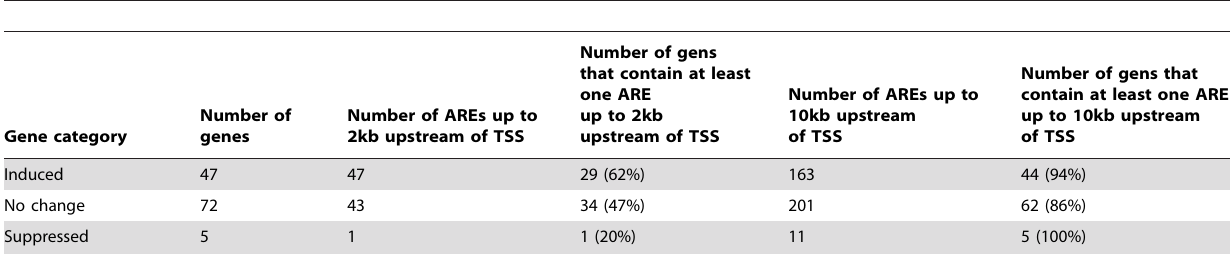
Table 1. Summary of total number of AREs in the 5 9 region of drug processing genes that were induced, not changed, and suppressed in the Nrf2 ‘‘gene dose-response’’ model.